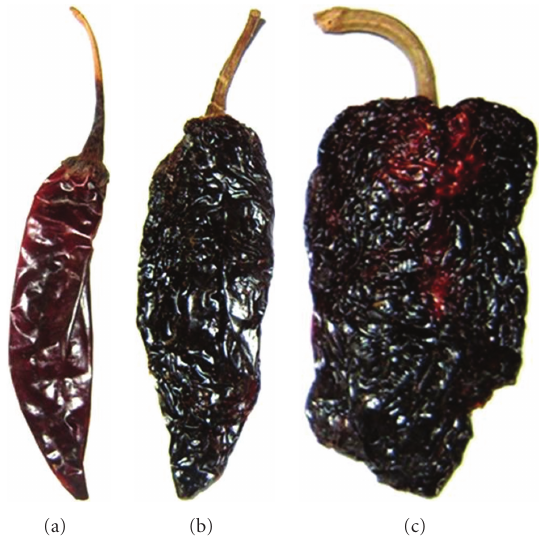
Figure 1: Capsicum annuum L. fruits employed in this study. Guajillo pepper (a), pasilla pepper (b), and ancho pepper (c).